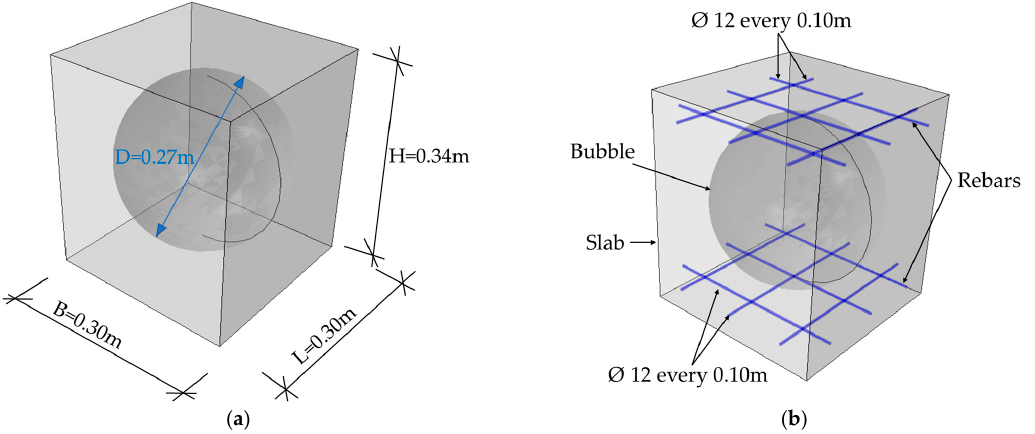
Figure 1. RVE-1—BD340: ( a ) geometry; ( b ) rebars. In the model, the concrete cross-section was divided into C3D10 solid elements, i.e., 10-node quadric tetrahedron elements with three degrees of freedom with dimensions of 0.05 m in each RVE direction. The steel reinforcement was meshed with truss elements T3D2 (2-node truss elements with three degrees of freedom according to [37]). The discretization which translates to 27,594 degrees of freedom (since all the elements have three degrees of freedom in each node).